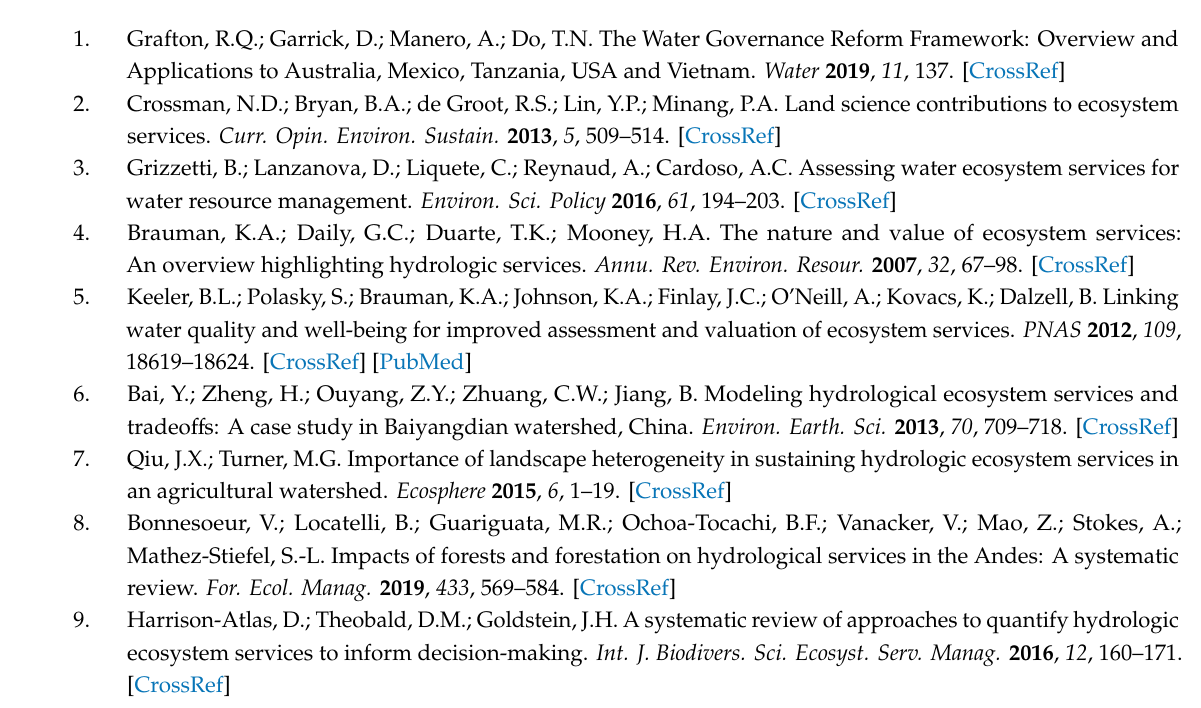
Figure S1: LISA simulated water yields (baseline), Figures S2–S6: LISA simulated water yields by CCSM4, CESM1-CAM5, GISS-E2-R, HadGEM-2-AO, MICROC5 under RCP2.6 and 8.5, Figures S7–S9: Sediment export, N export, P export of October simulated by LISA using 5 GCMs under RCP2.6 and 8.5, Tables S1–S4: Monthly water yield, sediment export, N export, and P export calculated in di ff erent climate change